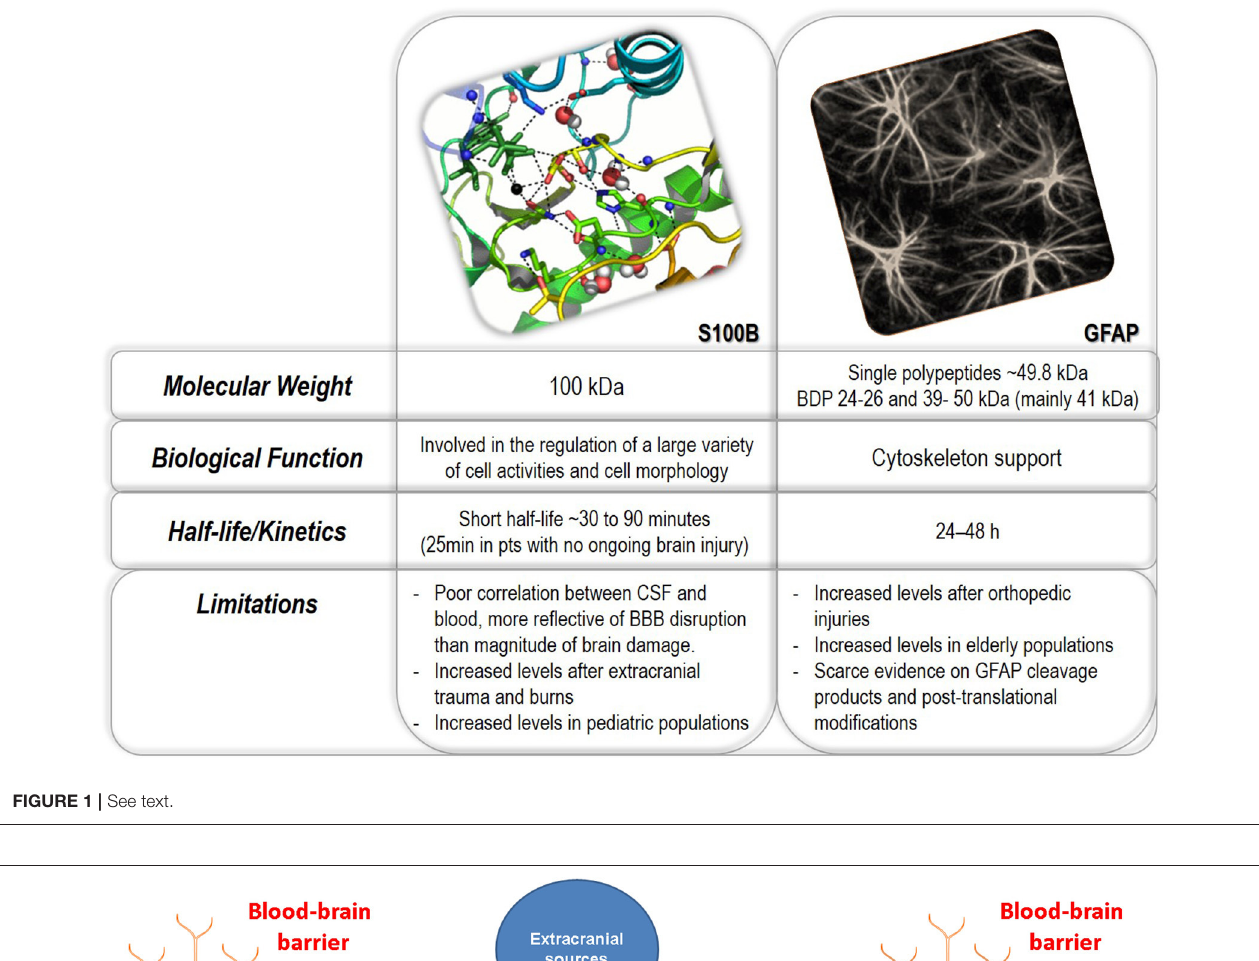
FIGURE 1 | See text.